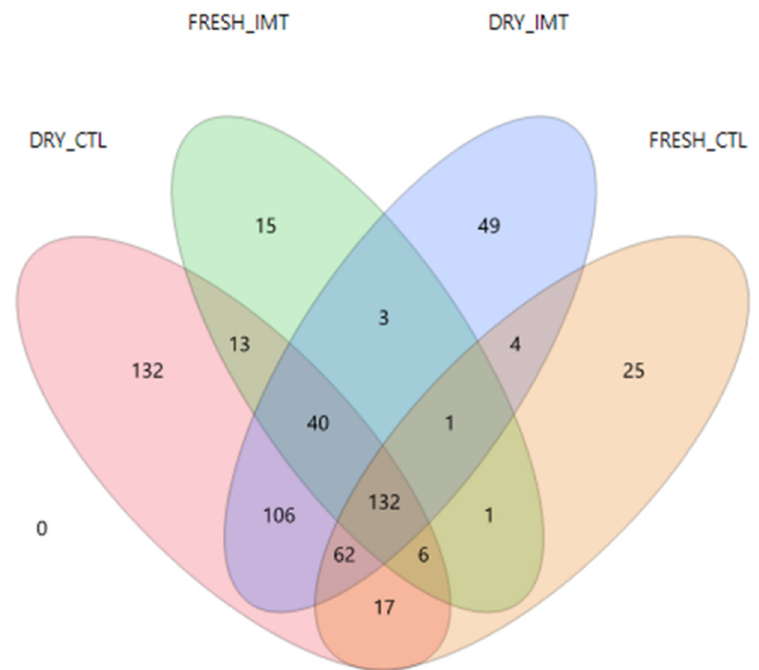
Figure 2. Venn diagram of the amplicon sequence variants found in milk samples from cows receiving intramammary antimicrobial treatment at dry-off (DRY and IMT), cows not receiving IMT at dry-off (DRY and CTL), and the follow up samples for these cows when fresh (FRESH and IMT, and FRESH and CTL, respectively). IMT: treatment group representing cows receiving intramammary antimicrobial drug treatment at dry-off; DRY: samples collected at the time of dry-off; FRESH: samples collected from post-partum cows between 4 and 11 days in milk; CTL: control group representing cows not receiving intramammary antimicrobial drug treatment at dry-off.